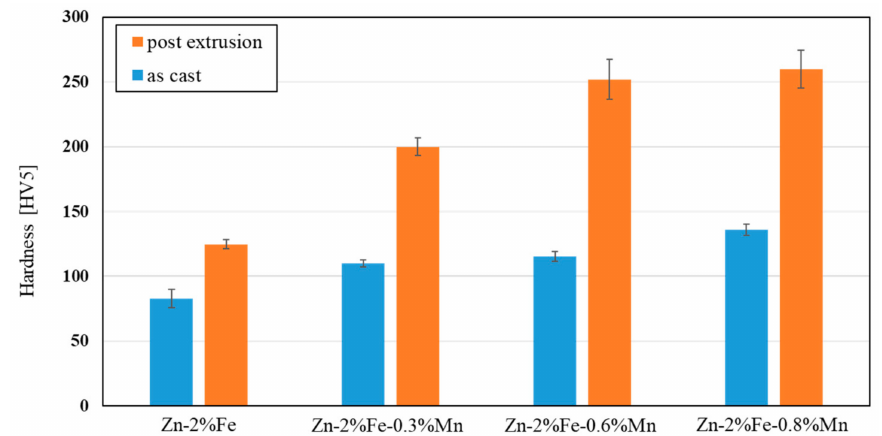
Figure 5. Hadrness measurement of Zn-2%Fe alloy with Mn additions in as-cast and post extrusion